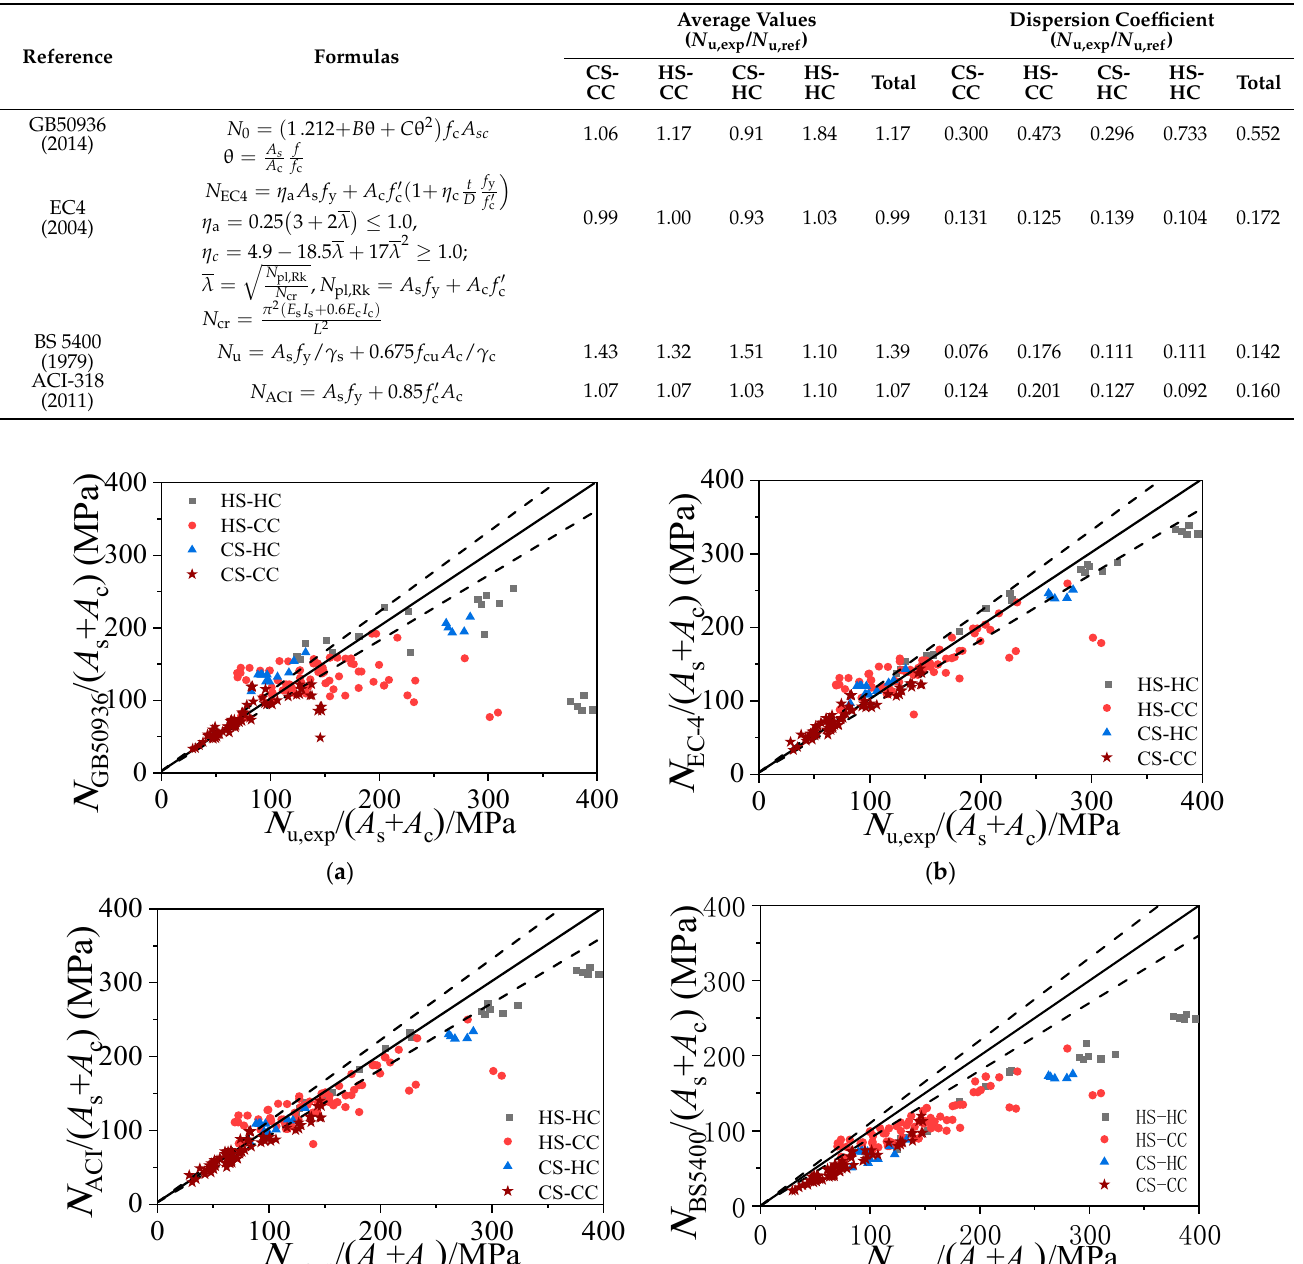
Table 3. Summary of available formulas in well-known national codes.